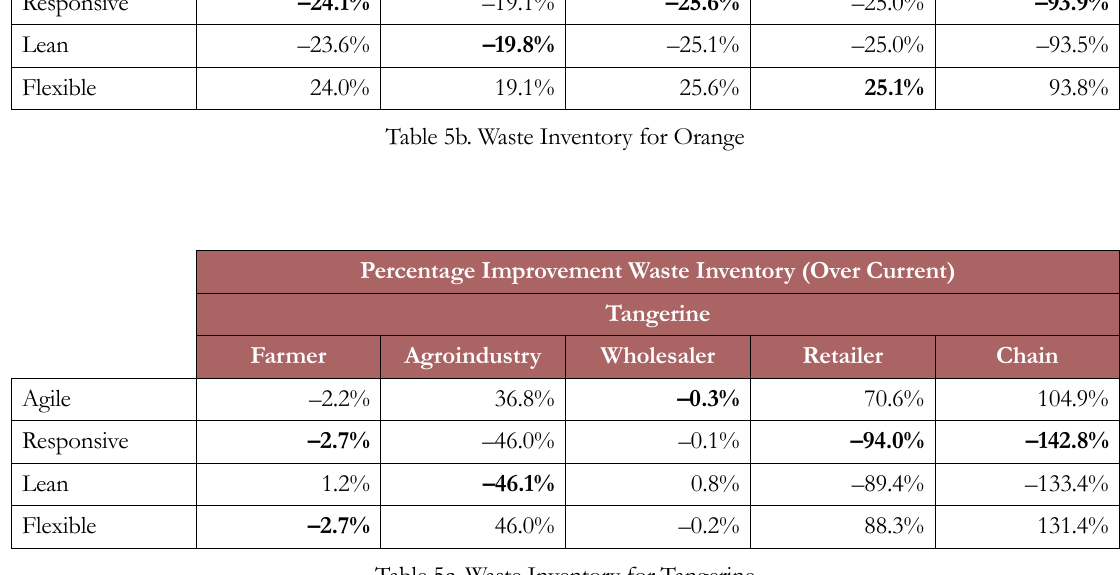
Table 5c. Waste Inventory for